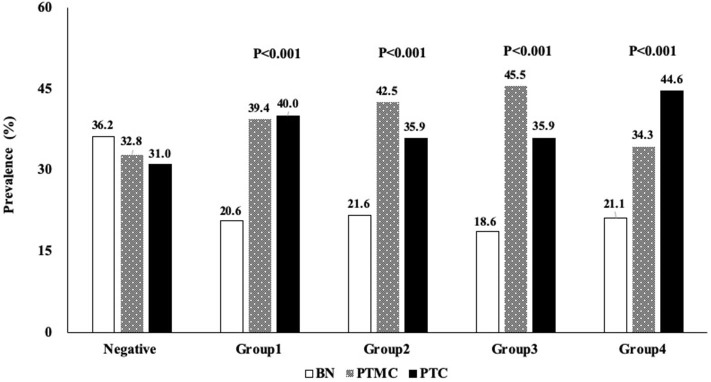
Profile showing the percentage distribution of 4 groups of patients with different serum TgAb titer who were diagnosed with BN, PTMC, or PTC. BN, benign; PTC, papillary thyroid cancer; PTMC, papillary thyroid microcarcinoma; TgAb, anti-thyroglobulin antibody.